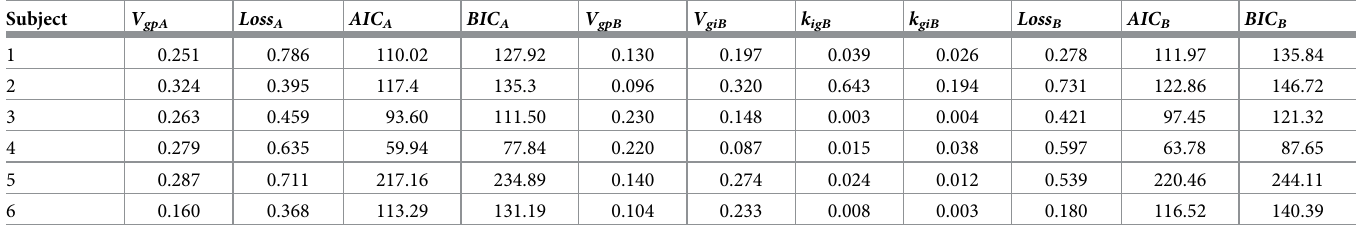
Table 4. Distribution volumes, loss, Akaike (AIC) and BIC criterium in the two model formulations: one-glucose compartment model (A) vs glucose two-compart- ments model (B). For Model B also the transfer rates between plasma and interstitium are